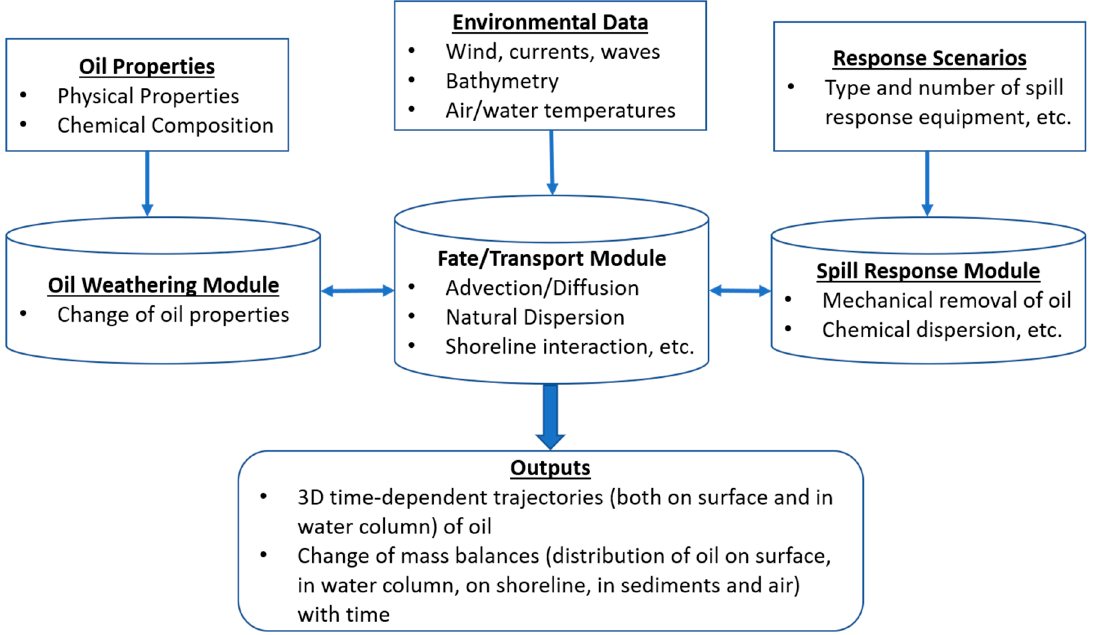
Figure 4. Schematic overview of a general oil spill model. Modified based on [30].